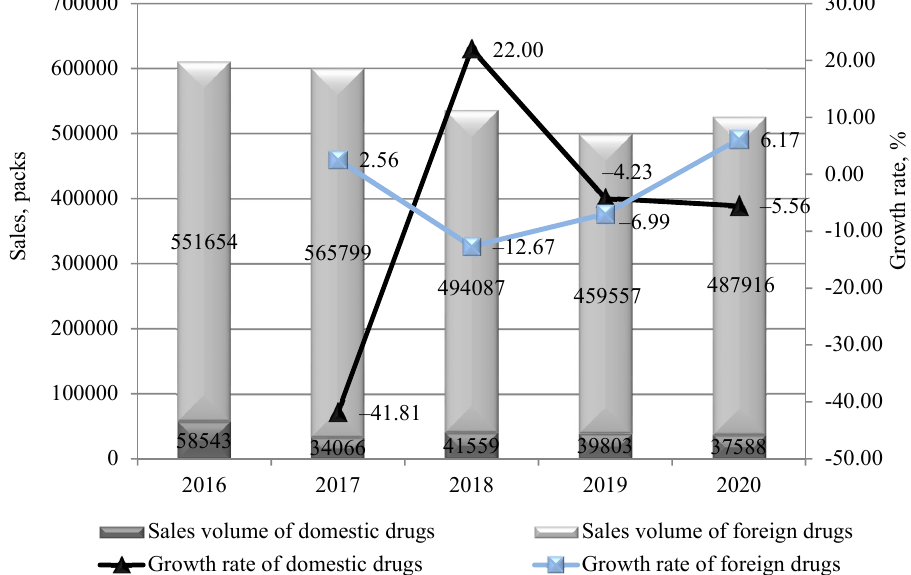
Fig. 2. Dynamics of indicators of retail sales of antiepileptics in physical terms for the pharmaceutical market of Kazakhstan